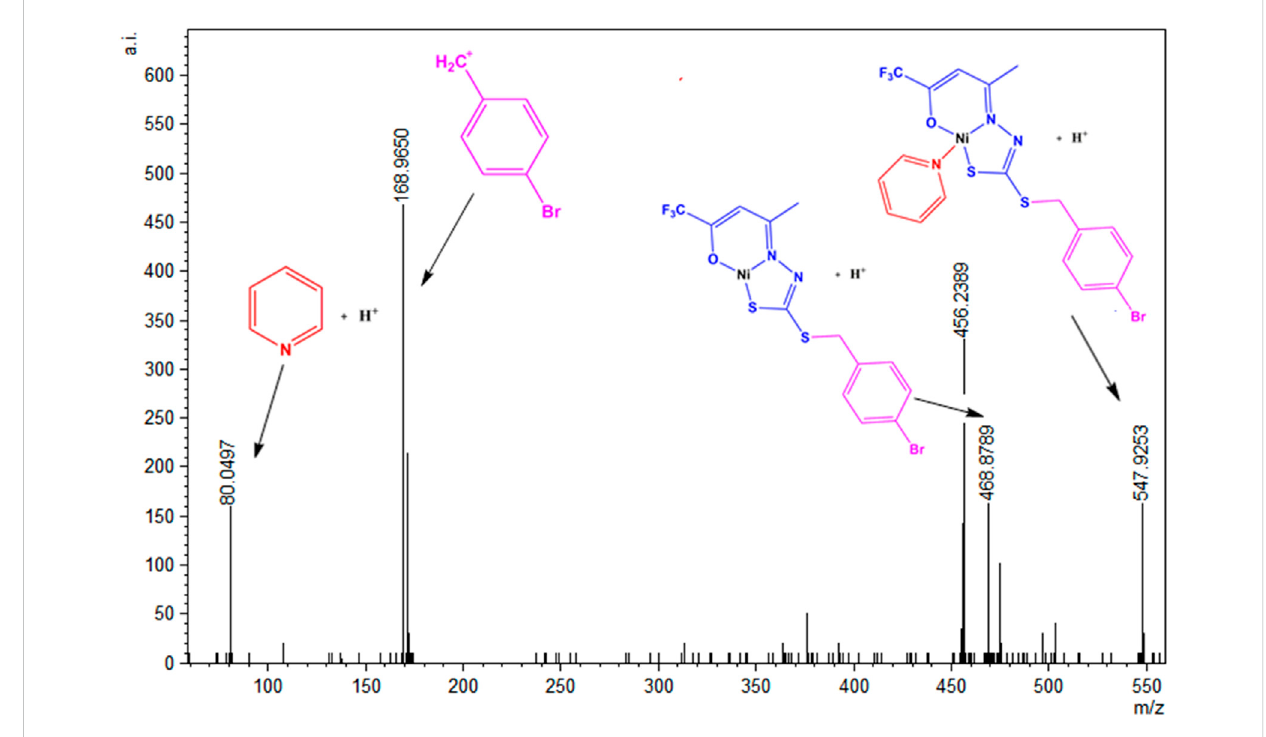
ESI(+)-MS/MS spectrum for